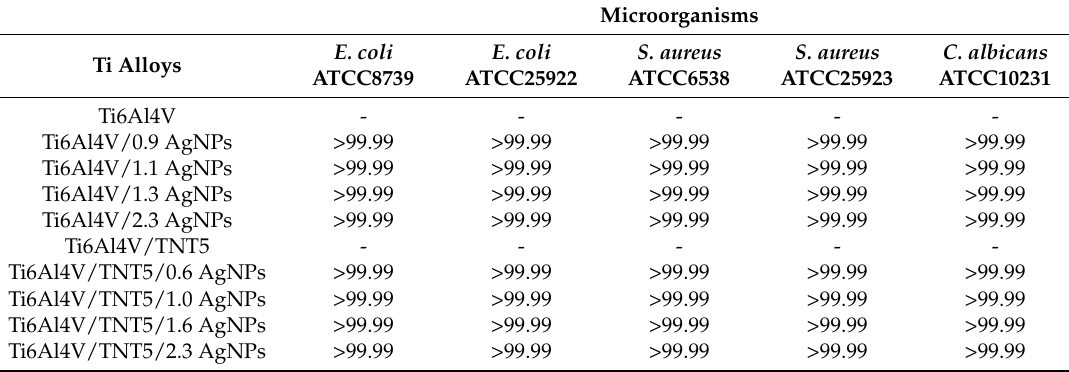
Table 4. The reduction of microbial growth (%) in PBS after the use of Ti6Al4V/AgNPs and Ti6Al4V/TNT5/AgNPs alloys for 14 days of ion